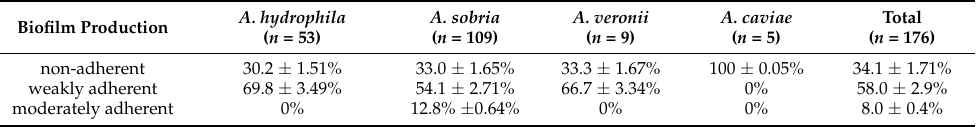
Table 4. Biofilm production of Aeromonas isolates in microtiter